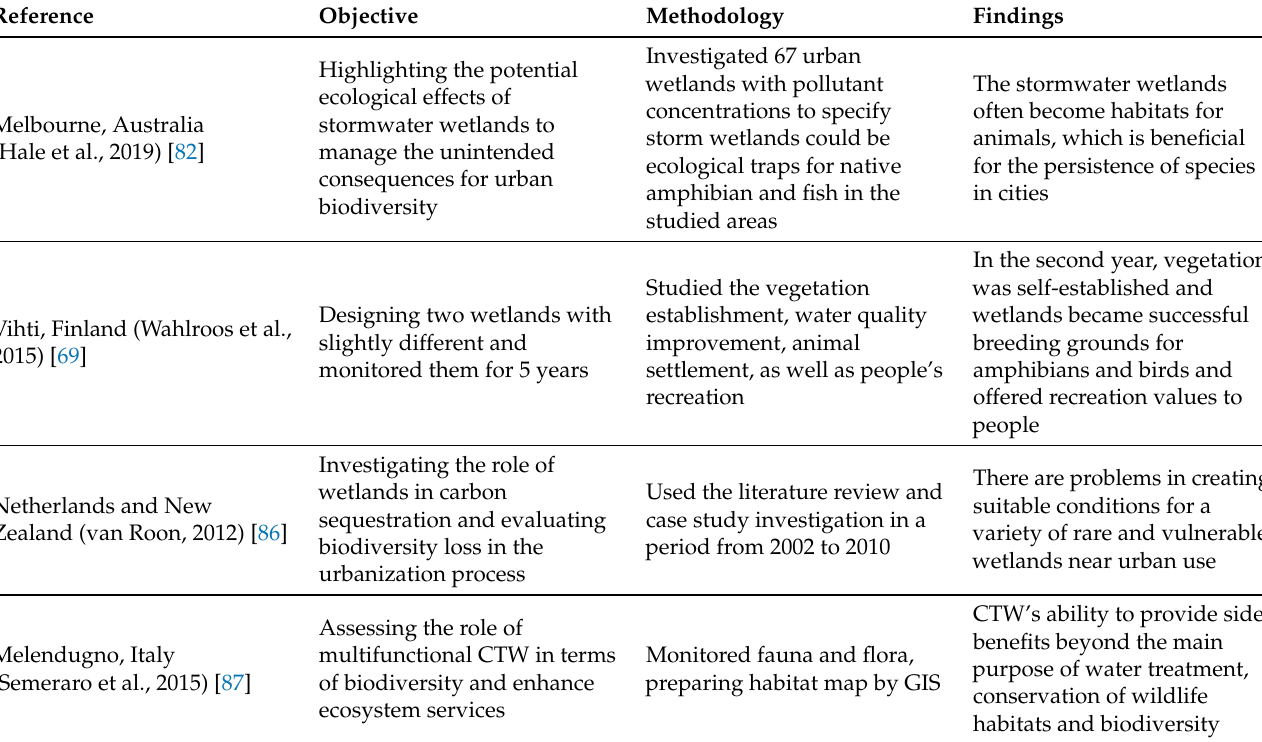
Table 2. Urban wetlands and